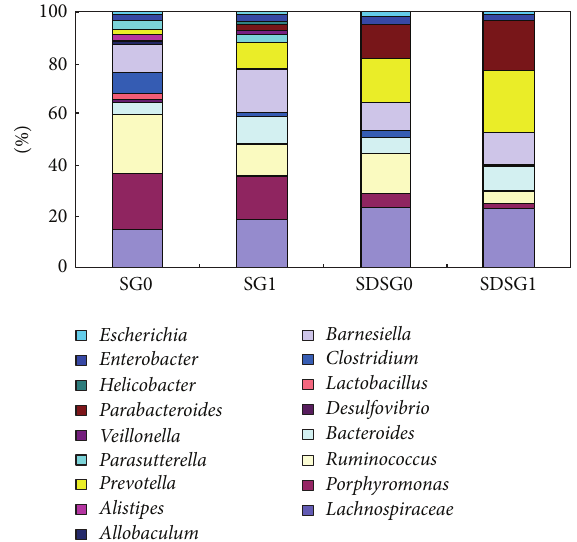
Figure 6: Taxonomic structure of diabetic rat intestinal flora before sleeve gastrectomy and one month after sleeve gastrectomy. Sleeve gastrectomy group (SG0, SG1) and sleeve gastrectomy of SD rats group (SDSG0,